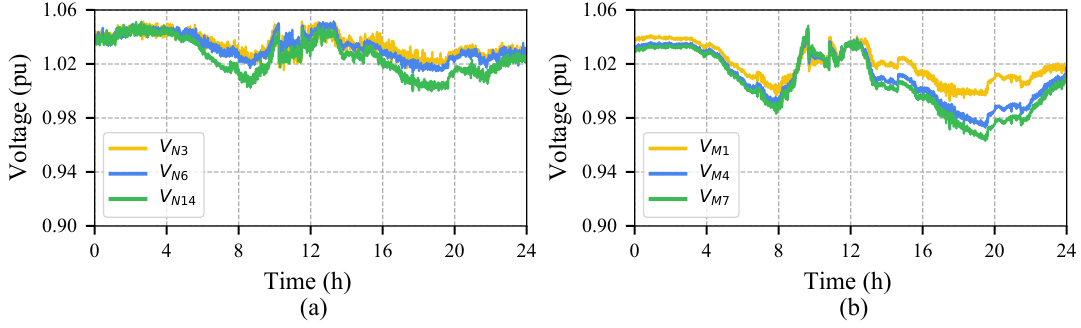
Figure 13. PSHIL-2. Impact on the MV and LV distribution networks. ( a ) 24-h evolution of the MV network voltages at buses N3, N6, and N14. ( b ) 24-h evolution of the LV network voltages at buses M1, M4, and M7.